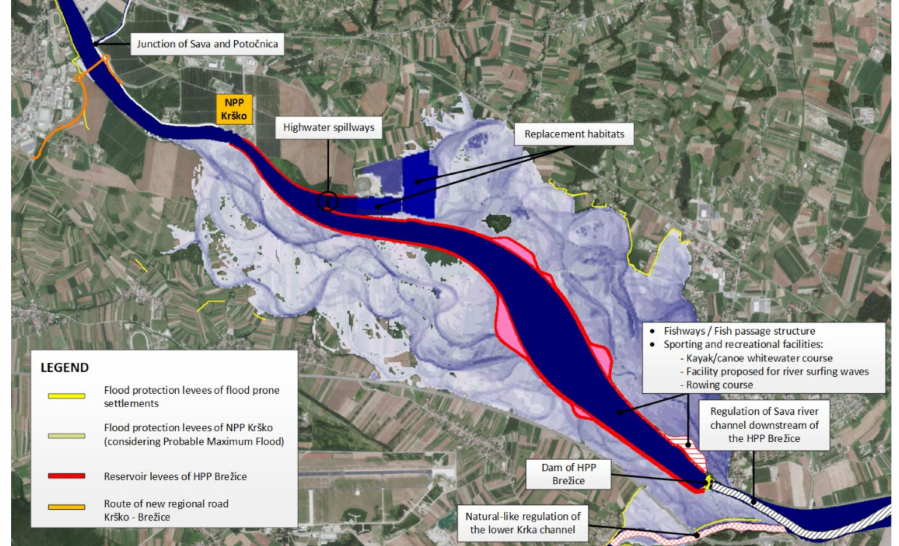
Figure 4. Situation around Brežice HPP, Sava